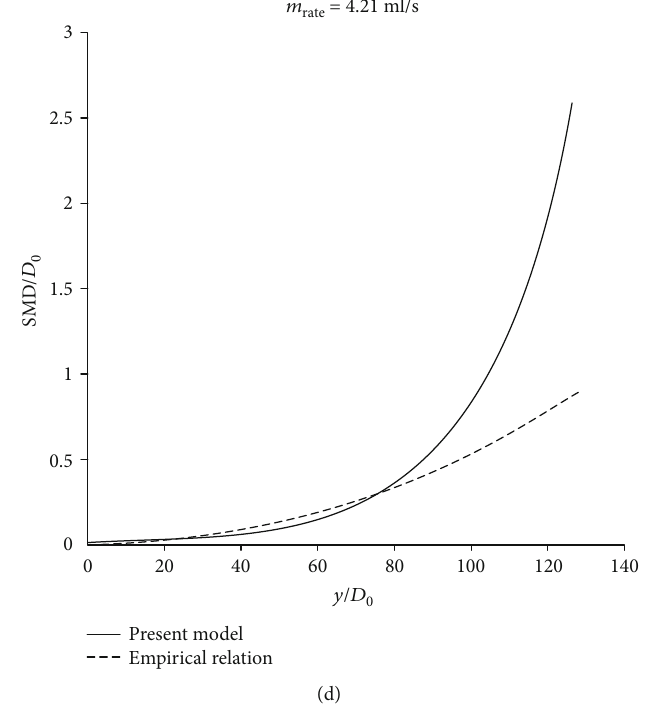
Figure 2: Comparison of the SMD spatial distribution between present model predictions and empirical relation by Kihm et al. [27]. ð a Þ = 1 : 58 ml/s . ð b Þ m = 2 : 63 ml/s . ð c Þ m = 3 : 15ml/s . ð d Þ m = 4 : 21ml/s . m rate rate rate rate